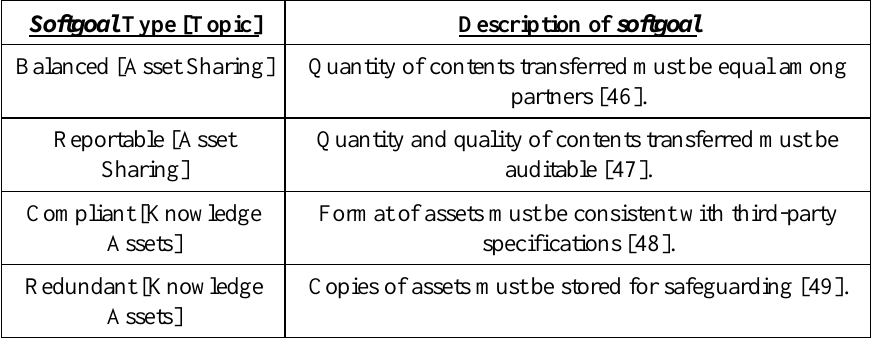
Table 3. Softgoal types and topics and topics in To-Be scenario in Figure 5